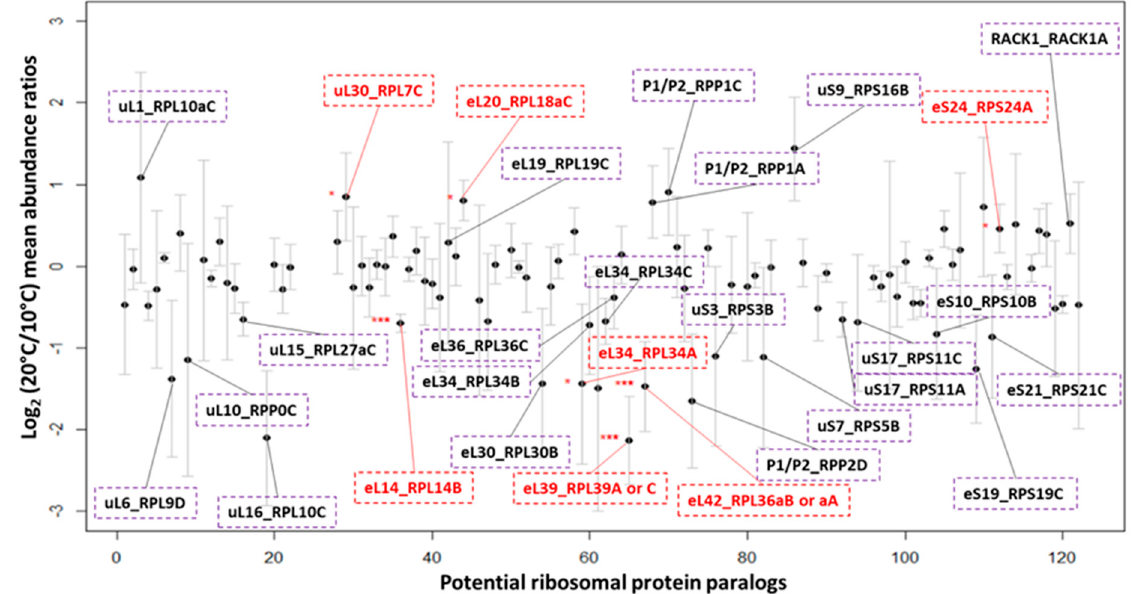
Figure 5. RP candidates of temperature-induced rearrangements in active translating ribosomes. Mean Log 2 ratios of 20 °C/10 °C ribosomal protein abundances during cold acclimation in Arabidopsis thaliana roots across independent genotypes in polysomes ( n = 4; dko1 , dko2 , WT-DS1, WT-DS2 outlined in Table S5). The abundances were LFQ-normalized and corrected to the total amount of protein per ribosomal subunit in order to avoid relative subunit abundance to influence the results (Table S3). The x-axes contains 123 ribosomal proteins in common between two independent shotgun proteomics runs. The y-axis contains the mean Log 2 ratios of normalized abundances and the error bars represent the standard error. Only RPs with a Log 2 ratio >0.5 or < − 0.5 have been named in the plot. In order to account for RPs that were cold-specific in at least one replicate causing an -inf as a result of the ratio, -inf was replaced by − 2 only for graphical purposes. This means that those values did not affect the statistical testing. Statistical testing (p Values < 0.01 = ***; > 0.01 ^ < 0.05 = **; >0.05 ^ < 0.1 = *) was done by fitting a GLM of the Gaussian family after testing the distribution of protein abundances using R functions compiled in the GitHub repository RandoDiStats (https://github.com/MSeidelFed/RandodiStats, accessed on 30 April 2021) and realizing that after normalization proteins in our datasets approximate a normal distribution (Figure S2).